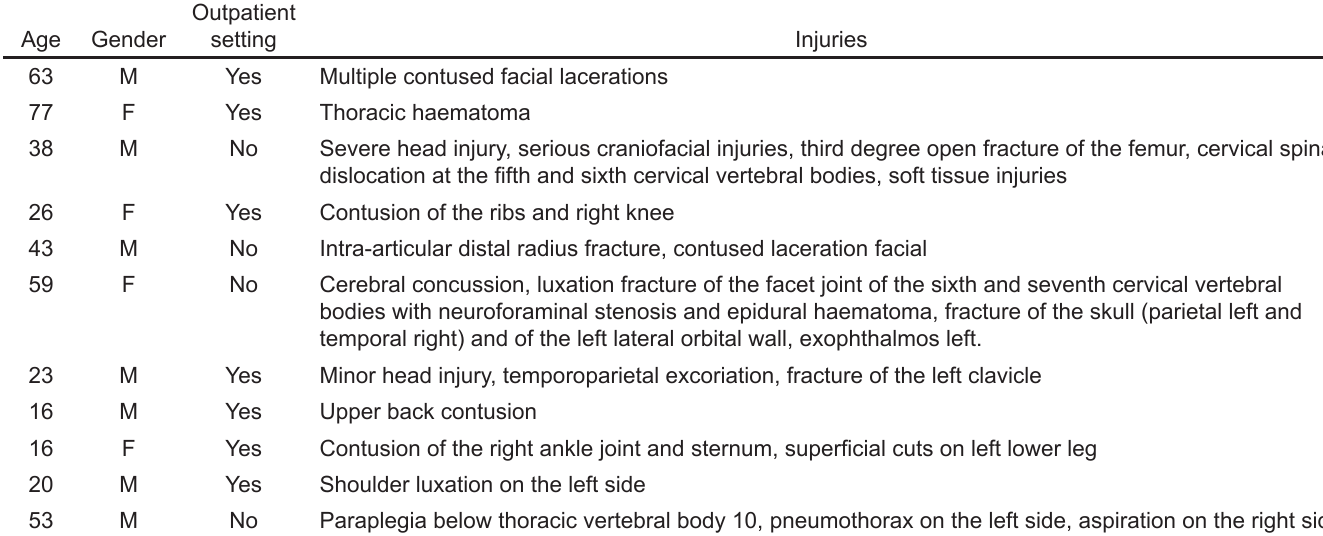
Table . Patient characteristics and traumatic injuries associated with